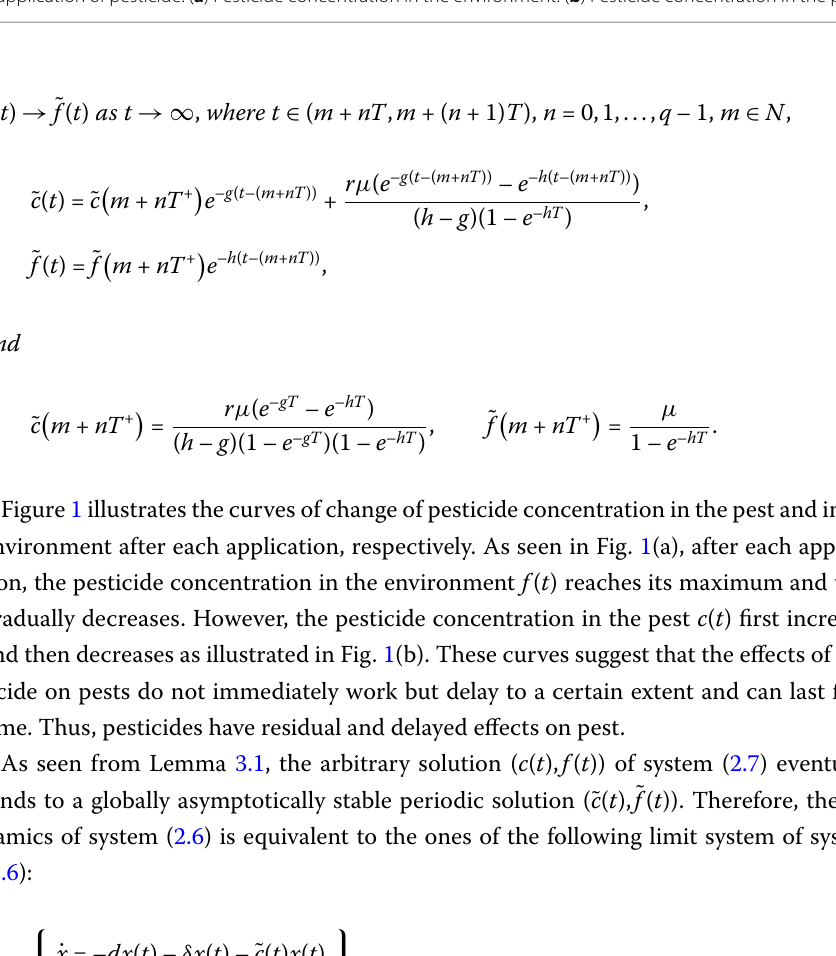
Figure 1 The curves of change of pesticide concentration in the pest and in the environment after each application of pesticide. ( a ) Pesticide concentration in the environment. ( b ) Pesticide concentration in the pest